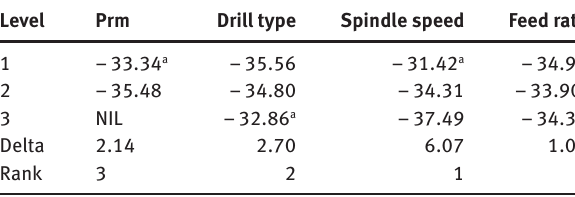
Table 6: Response table for S/N for torque.